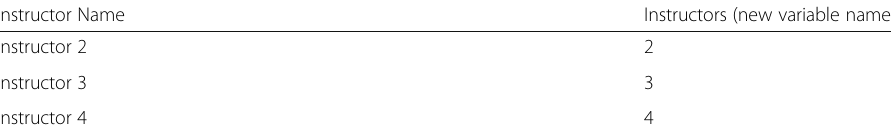
Table 5 Encoding instructor